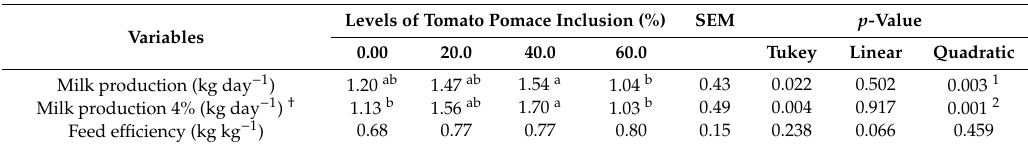
Table 3. Milk production, feed e ffi ciency, and feed conversion of dairy goats fed with di ff erent levels of inclusion of tomato pomace.